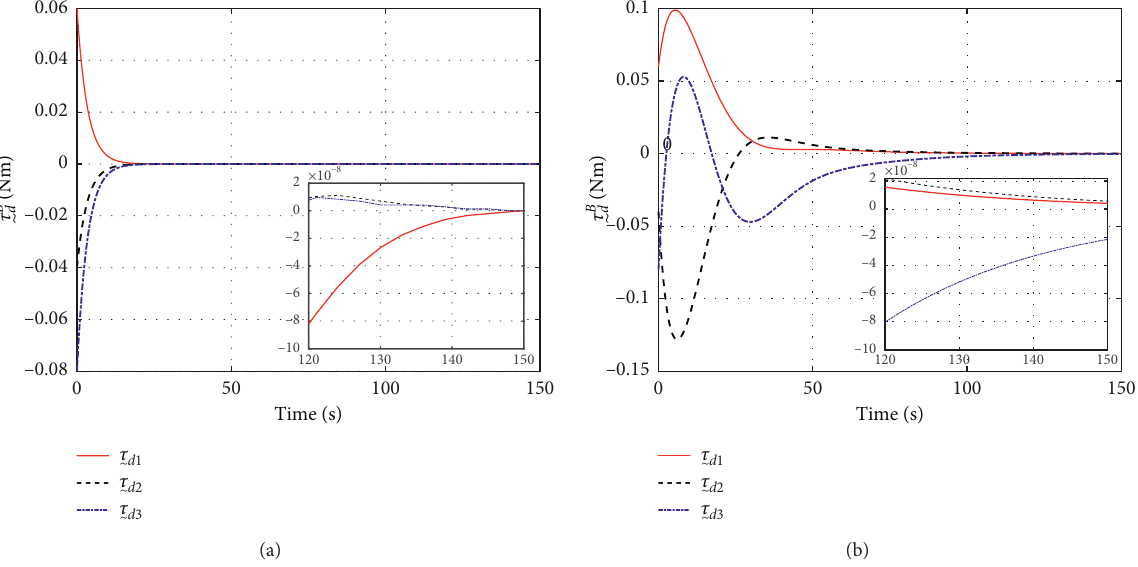
Figure 9: Disturbance torque estimation errors. (a) I&I-based adaption law. (b) CE-based adaption law.